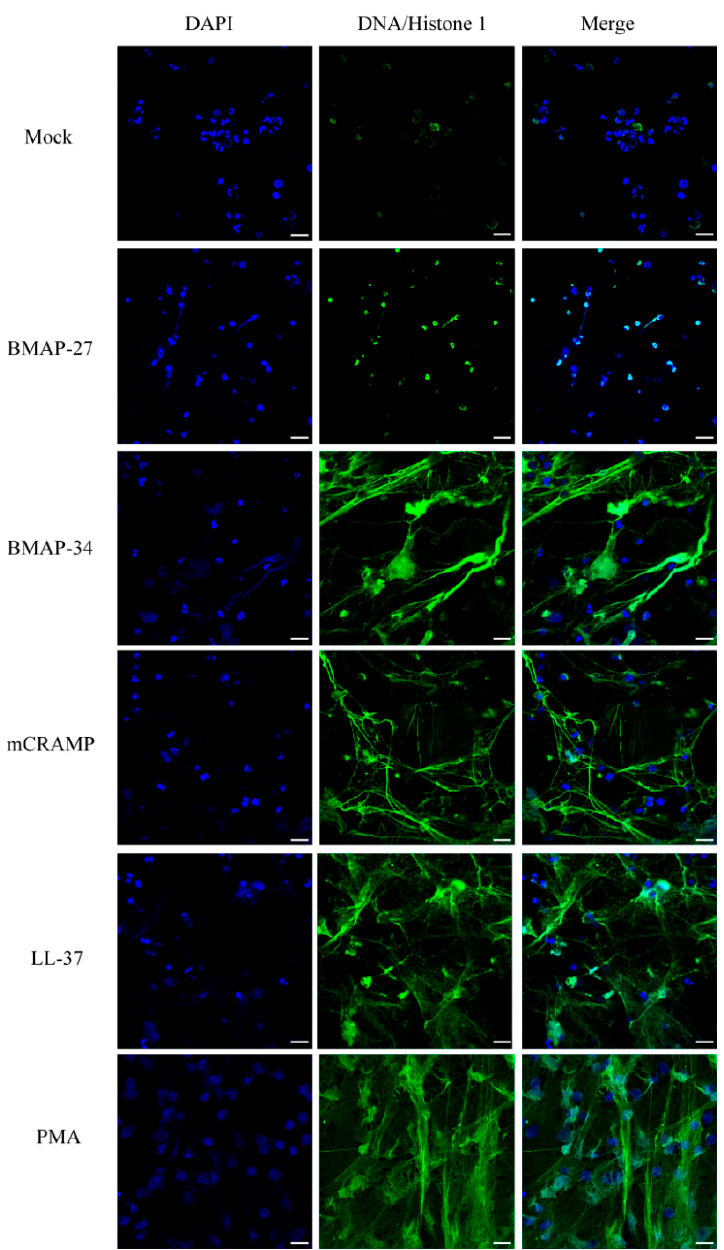
Figure 8. Mammalian cathelicidins promote the NETs formation. Fluorescence microscopic Figure8. MammaliancathelicidinspromotetheNETsformation. Fluorescencemicroscopicvisualization visualization of NETs formation stimulated by BMAP-27, BMAP-34, mCRAMP, and LL-37 for 4 h at of NETs formation stimulated by BMAP-27, BMAP-34, mCRAMP, and LL-37 for 4 h at 37 ◦ C. NETs stimulated from human neutrophils were stained for DNA / histone 1 in green, nuclei in blue. Mock, unstimulated neutrophils. PMA, positive control. Scale bars = 20 µ